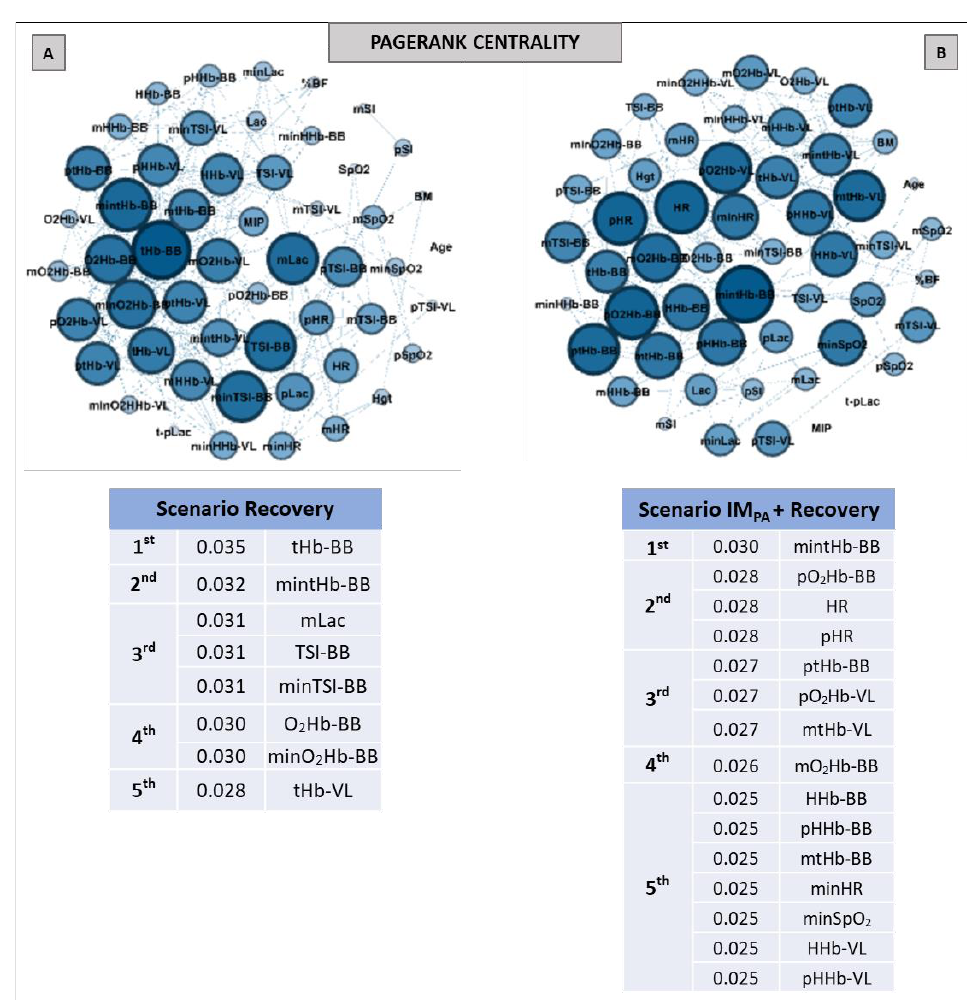
Figure 7. Graphs and top five node results obtained by complex network analysis using the Pagerank metric in two recovery scenarios: without inspiratory muscle pre-activation (Scenario Recovery, at Panel A ) and with inspiratory muscle pre-activation (Scenario IM PA + Recovery, at Panel B ). Graph visualizations were done using Gephi software (version 0.9.2, Paris, France). Legend: AO30 = all-out 30 s, IM PA = inspiratory muscle pre-activation, Hgt = height, BM = body mass, %BF = percentage of body fat, MIP = maximal inspiratory pressure, SI = global strength index of inspiratory muscles, Lac = blood lactate, HR = heart rate, SpO 2 = arterial oxygen saturation, O 2 Hb = oxyhemoglobin relative concentration, HHb = deoxyhemoglobin relative concentration, tHb = total hemoglobin, TSI = tissue saturation index. Abbreviations accompanied by p , m and min represent peak, mean and minimum values, respectively. Abbreviations accompanied by BB and VL represent the results in the biceps brachii and vastus lateralis, respectively.